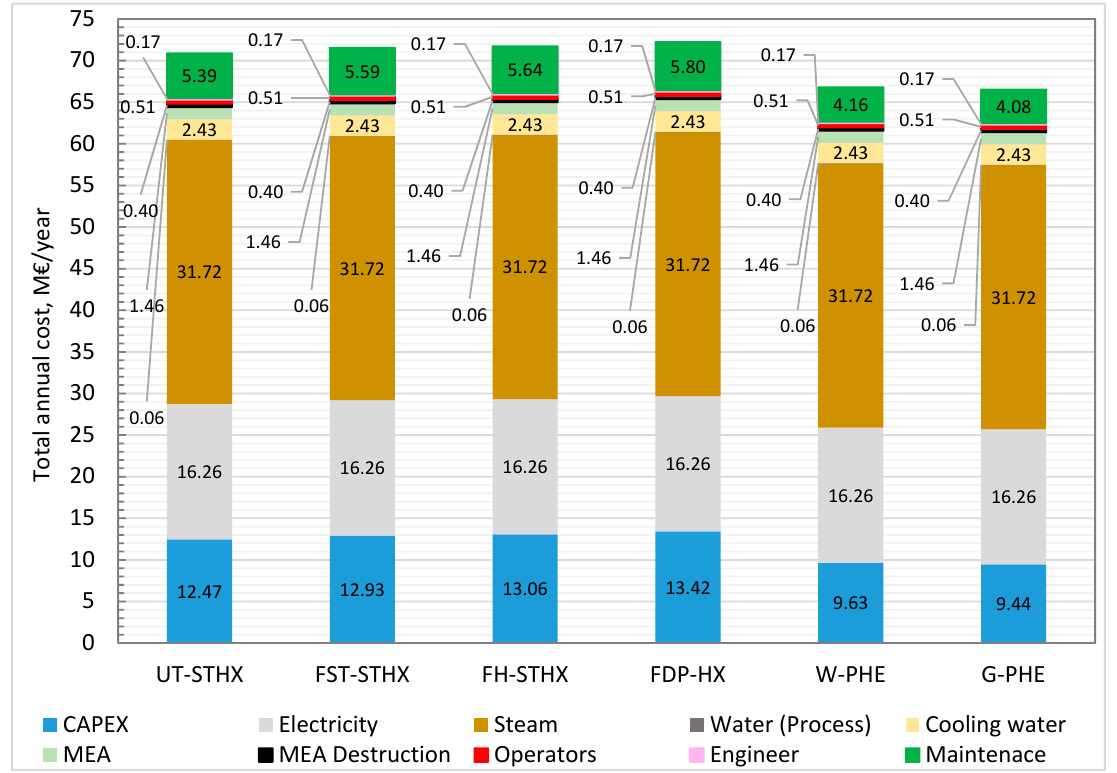
Figure 8. Comparison of total annual cost distributions. Table 6. Cost performance of all the capture plant scenarios.